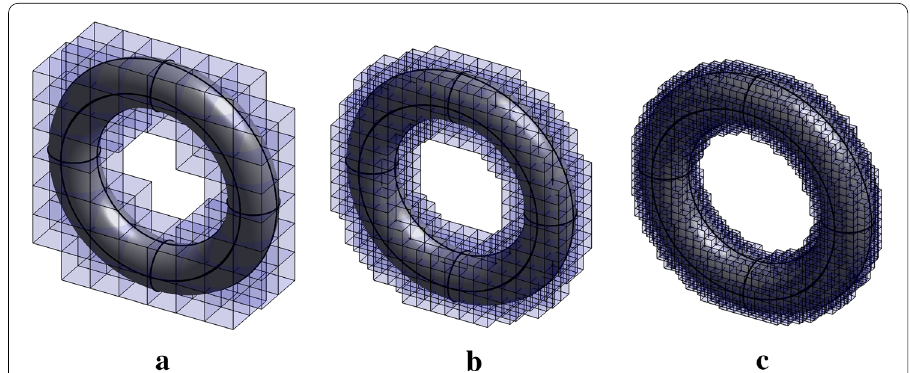
Fig. 12 Example 2. Refinement process for the analysis of contact between curved surfaces. Meshes 1 to 3 are shown from left to right. Both solids are meshed with a similar discretization. a 216 nodes. b 1052 nodes. c 5268 nodes